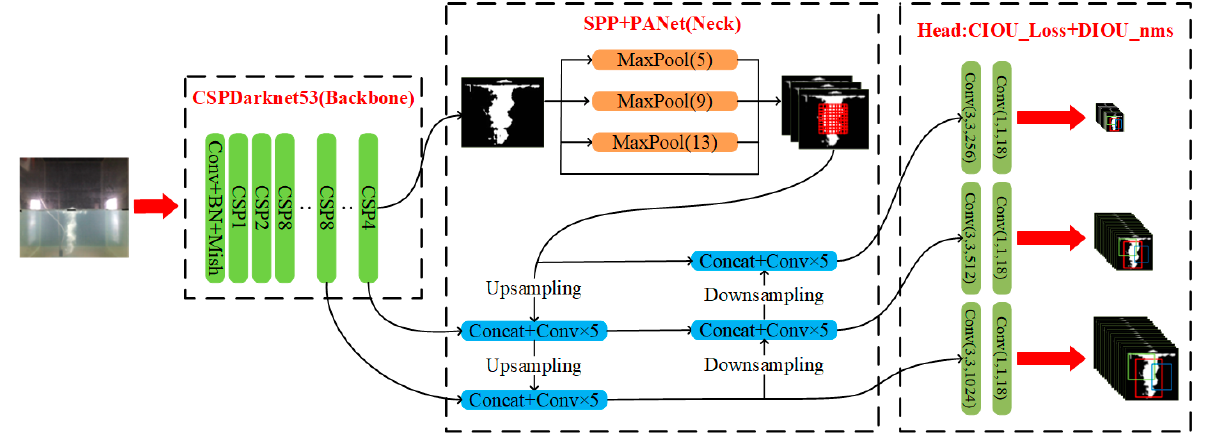
Figure 2. The overall YOLOv4 architecture.